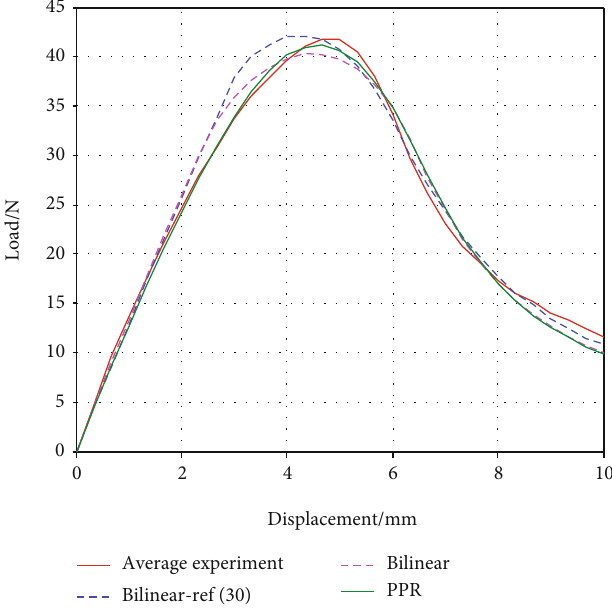
Figure 12: Average experimental and numerical load-displacement curves for DCSB